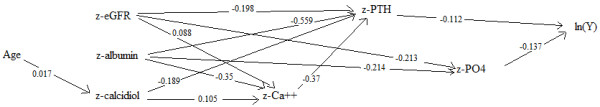
The parsimonious multivariate path model.